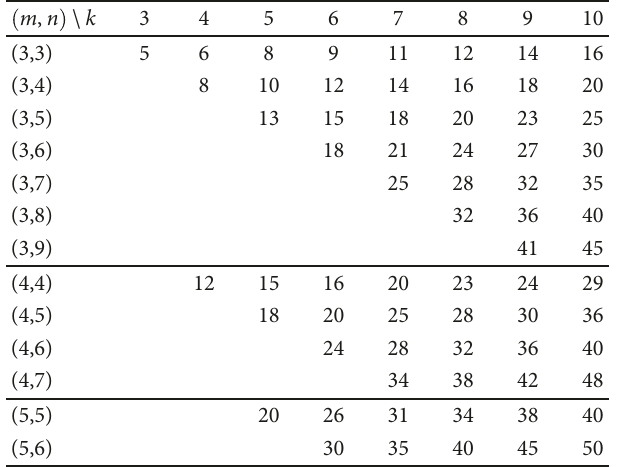
. Table 6: Bounds and exact values of γ T k m , n , k